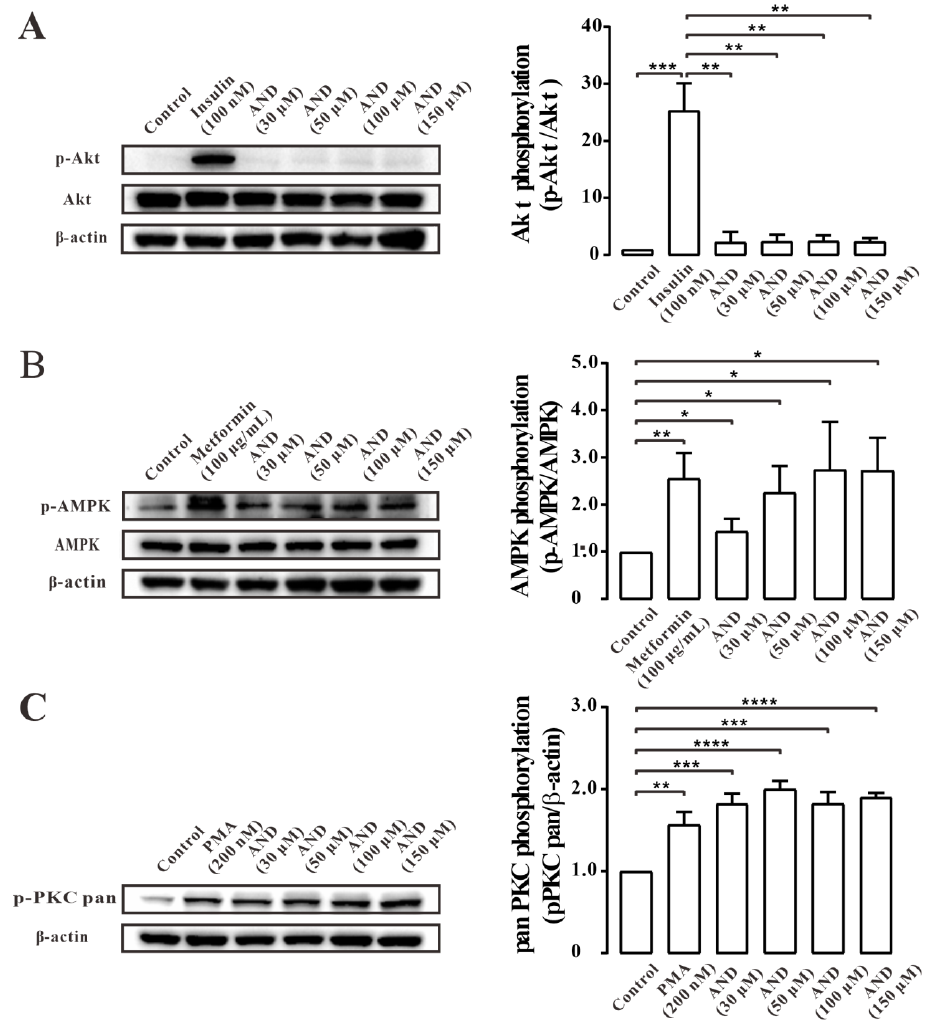
Figure 6. AND induced phosphorylation of PKC and AMPK signaling pathways. ( A ) The phosphorylation of Akt in L6 cells treatment with insulin and different concentrations of AND. The control group was considered as 1 for data analysis. The data represent the mean ± s.e.m. of values from three separate experiments. ( B ) The phosphorylation of AMPK in L6 cells treatment with metformin and different concentrations of AND. The control group was considered as 1 for data analysis. The data represent the mean ± s.e.m. of values from three separate experiments. ( C ) The phosphorylation of PKC in L6 cells treatment with PMA and different concentrations of AND. The control group was considered as 1 for data analysis. The data represent the mean ± s.e.m. of values from three separate experiments. *: p < 0.05; **: p < 0.01; ***: p < 0.001; ****: p <